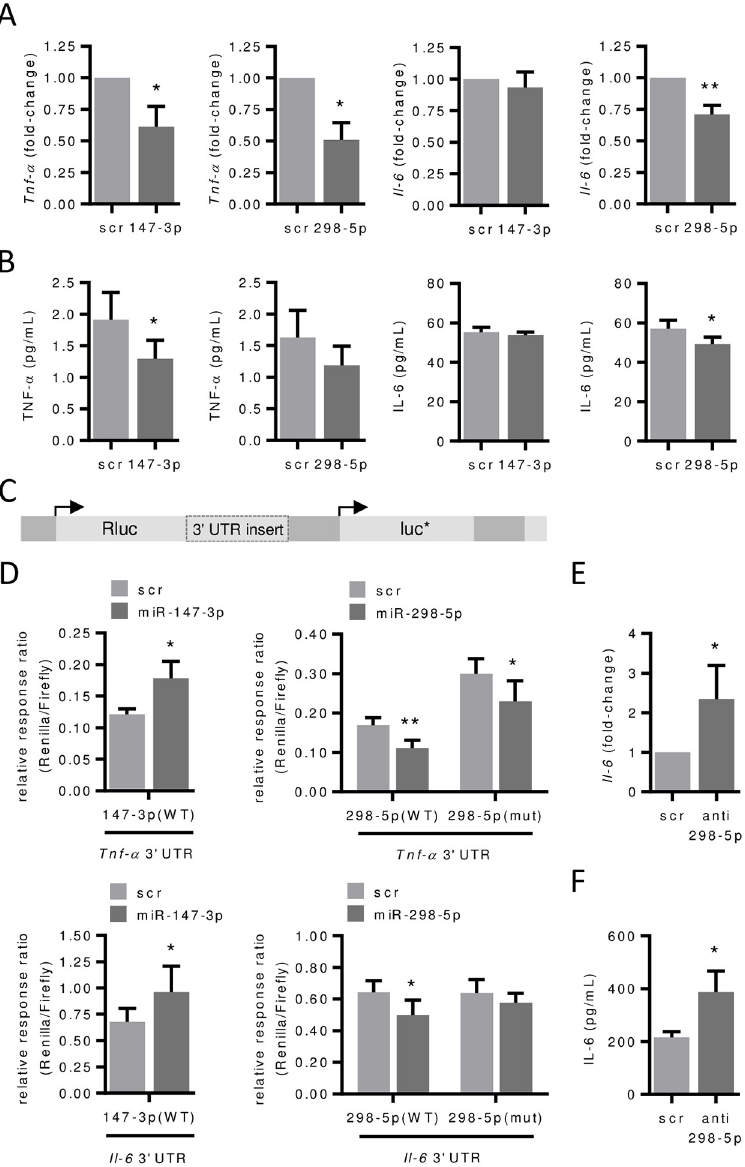
Fig 4. miR-147-3p and miR-298-5p control NOD1- and NOD2-dependent induction of Tnf- α and Il-6 in murine pulmonary endothelial cells. ( A ) Tnf- α and Il-6 mRNA levels and ( B ) TNF- α and IL-6 protein levels in the supernatant were analyzed 24 hours after transfection of scramble (scr) control, mimics for miR-147-3p or miR-298- 5p (25 pmol each) by real-time PCR or ELISA, respectively. � P < 0.05, �� P < 0.01 vs. scr, n = 4–5. ( C ) Essential elements in the luciferase reporter vector psiCHECK ™ -2 carrying an insert of the untranslated region (3’ UTR) of Tnf- α or Il-6 mRNA sequence downstream of the reporter gene. Rluc = Renilla luciferase, luc � = Firefly luciferase. ( D ) Reporter plasmids with 3’ UTR of (wild type = WT), Tnf- α or Il-6 mRNA or its mutated version (= mut, each 200 ng) were cotransfected with scramble (scr) control, mimics for miR-147-3p or miR-298-5p (each 30 pmol) into HEK-293T cells. Renilla luciferase activity was measured after 72 hours and normalized to Firefly luciferase activity. Relative response ratios of Renilla versus Firefly luciferase normalized to empty vector and mimic control are shown � P < 0.05, �� P < 0.01 vs. scr, n = 3–6. (E) Il-6 mRNA levels and (F) IL-6 protein levels in the supernatant were analyzed 24 hours after transfection of scramble (scr) control or anti-miR-298-5p (25 pmol each) by real-time PCR or ELISA, respectively. � P < 0.05, �� P < 0.01 vs. scr, n =